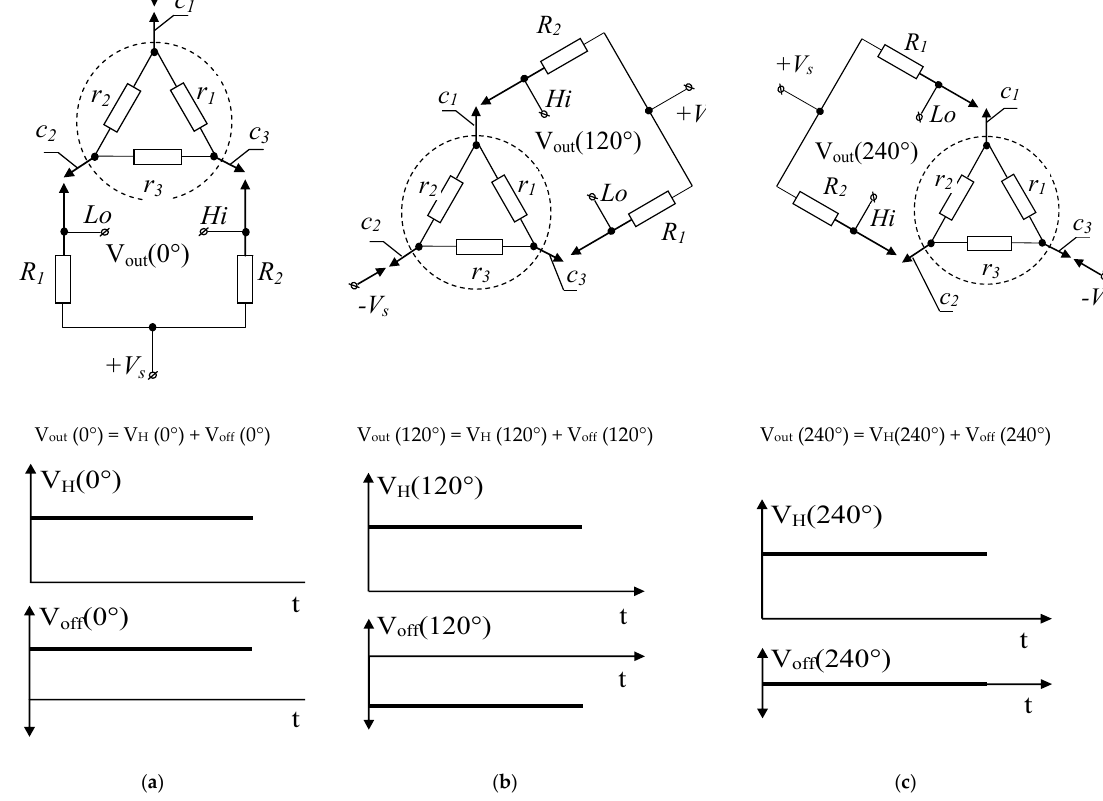
Figure 2. Measurement cycle for dynamic offset cancellation: ( a ) state 1; ( b ) state 2; ( c ) state